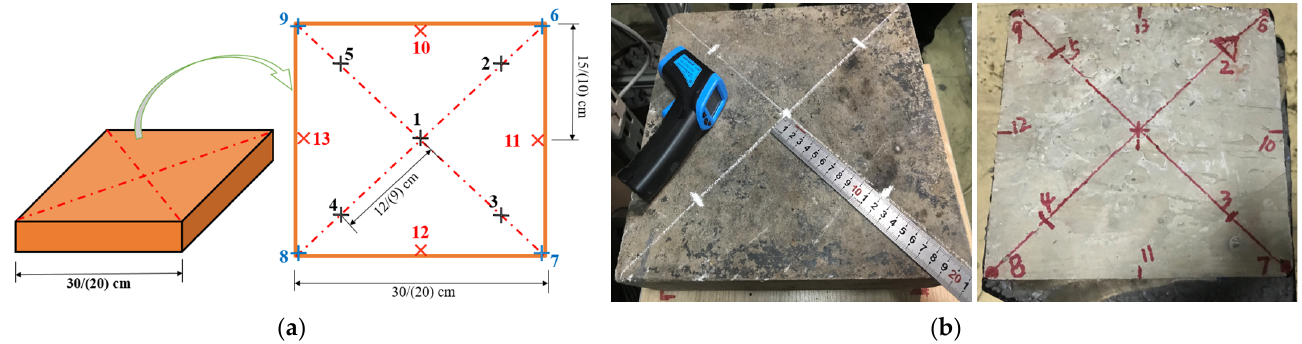
Figure 6. Arrangement of the measurement points on the surface of the concrete specimen: ( a ) Schematic diagram of concrete specimen; ( b ) Physical drawing of concrete specimen.